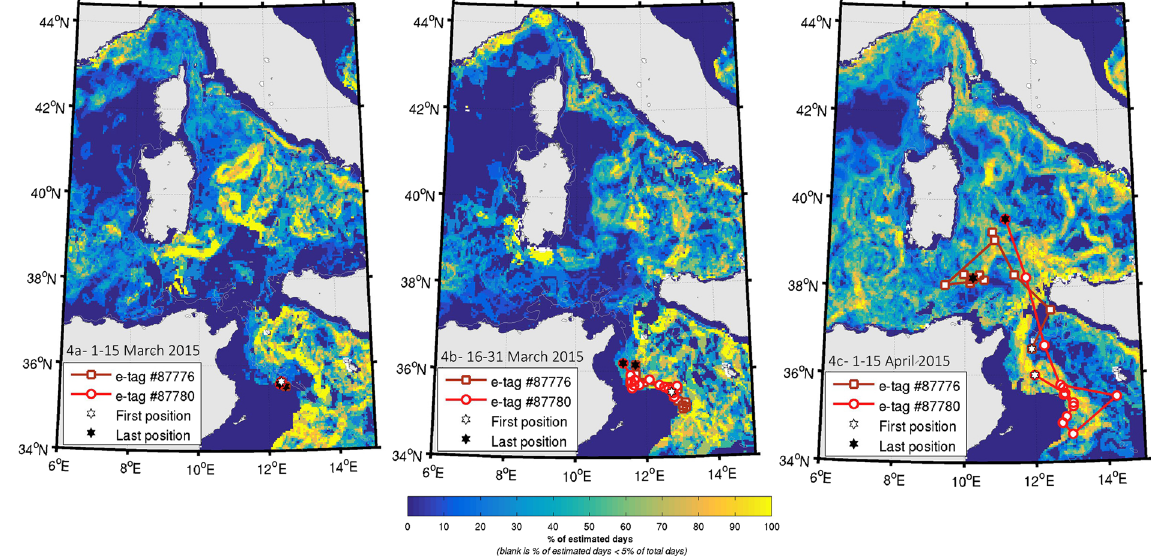
Figure 4. Two Argos satellite derived positions overlaid on fortnights mean potential feeding habitat (March- April 2015). Note that only one position per day is shown. The potential habitat of fin whale is derived from the daily detection of chlorophyll-a fronts, a range of surface chlorophyll-a content and a minimum water depth (see Supplementary materials for details). The 200 m depth contour is shown. The maps were prepared off-line using a commercial software package: MATLAB and Statistics Toolbox Release 2015b, The MathWorks, Inc., Natick, Massachusetts, United States (www.mathworks.com).